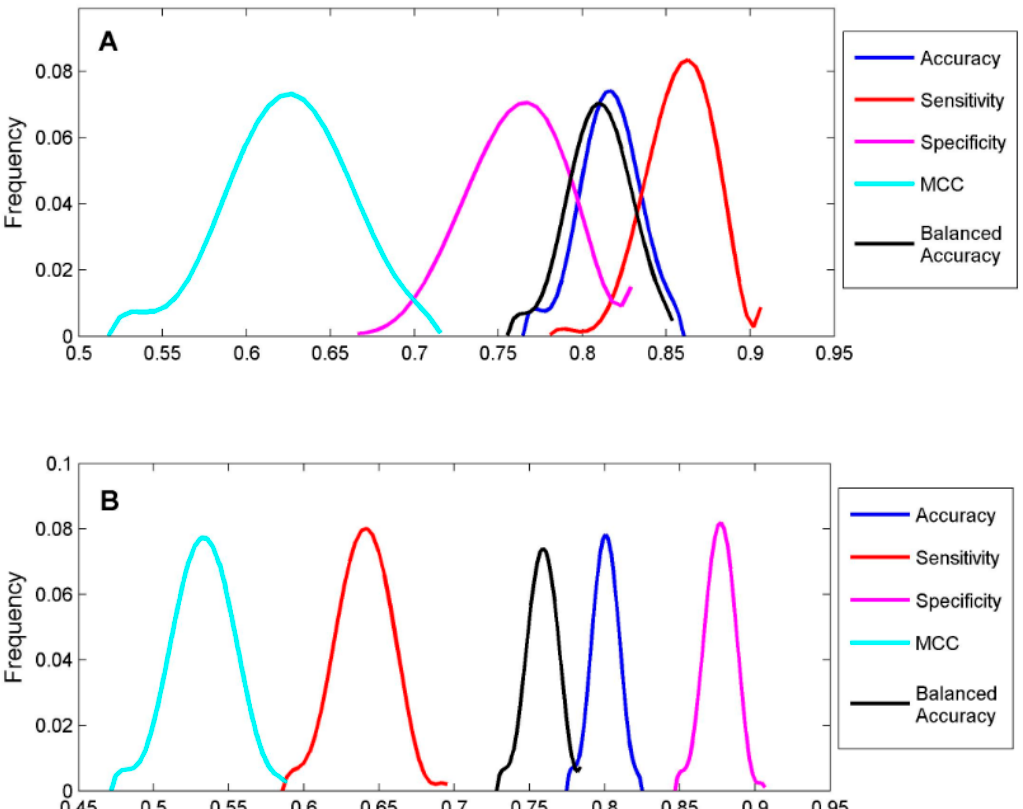
Figure 4. Classification performance of the 5-fold cross validations. Classification accuracy (blue),